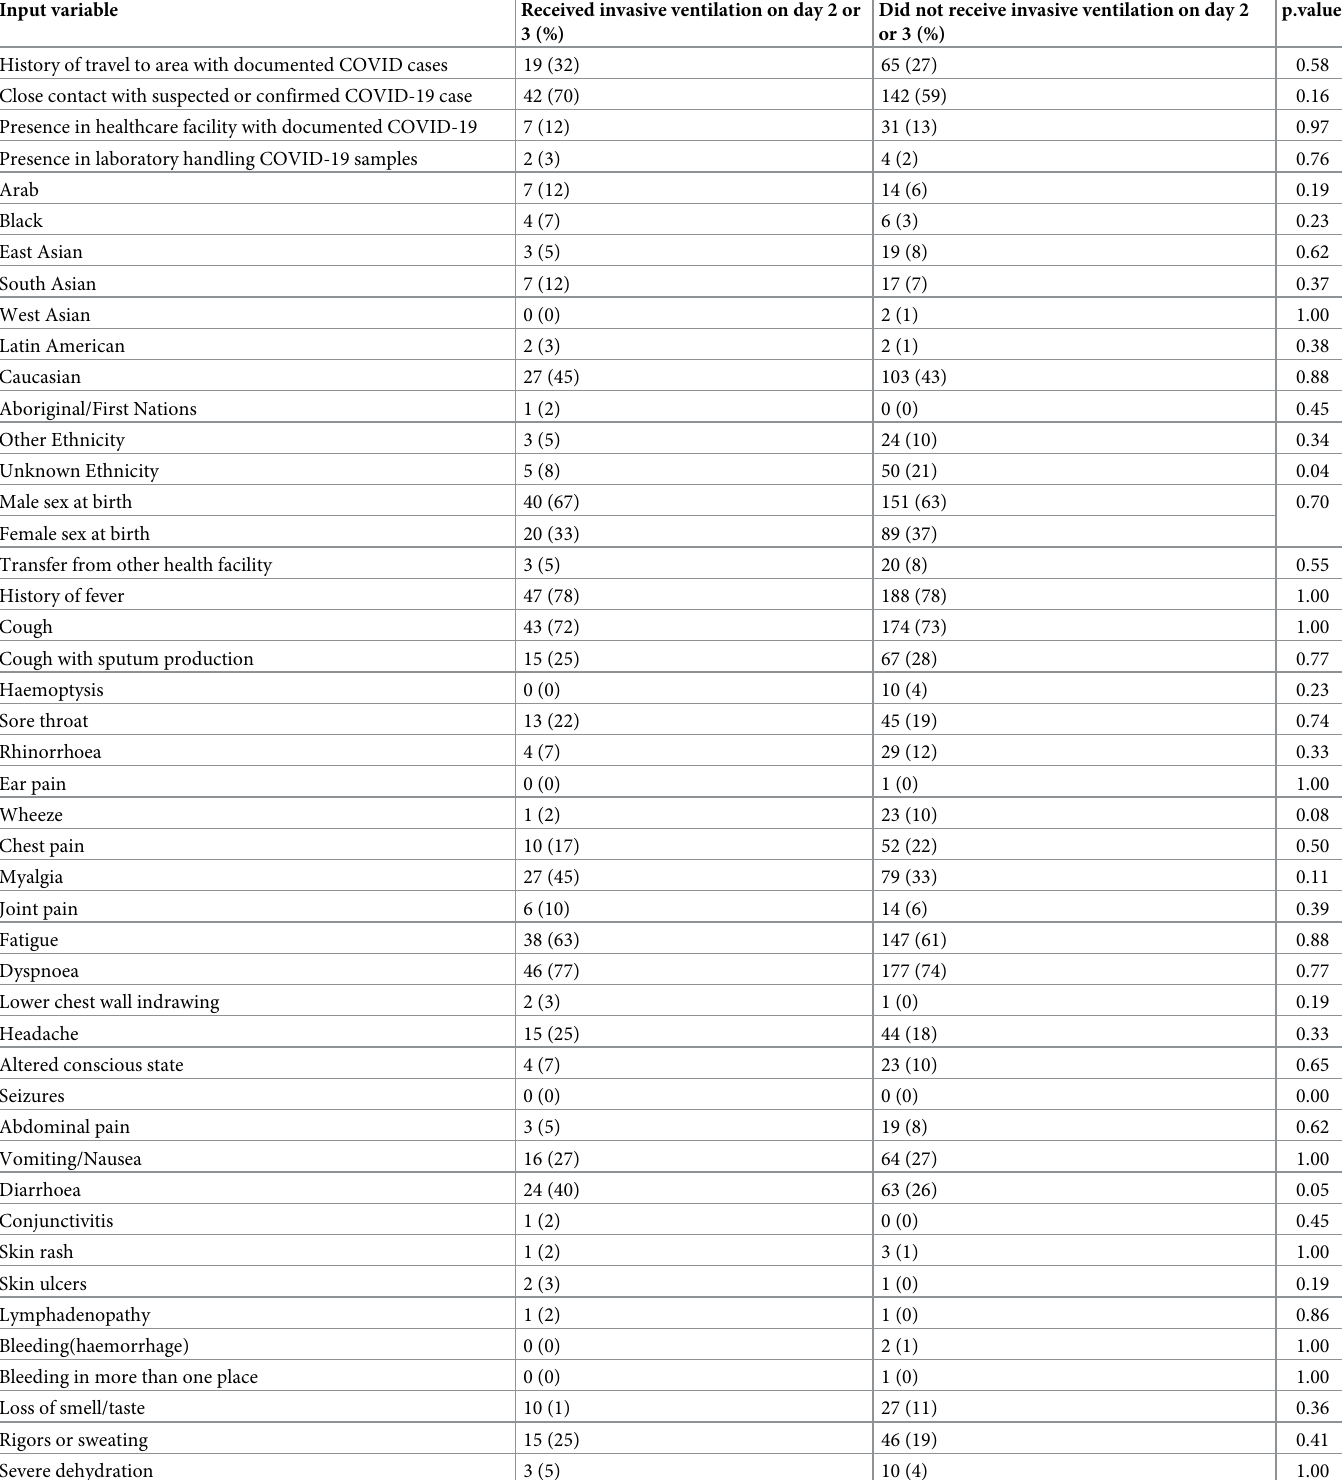
Table 1. Discrete input variables’ population characteristics and corresponding p-value (Pearson’s Chi-Squared